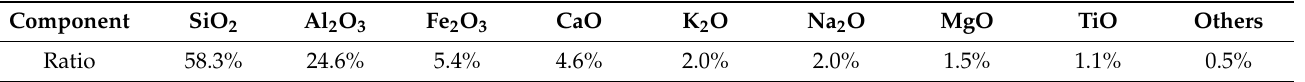
Figure 5. Fly-ash XRD ray spectrum. Table 1. Main chemical composition of fly